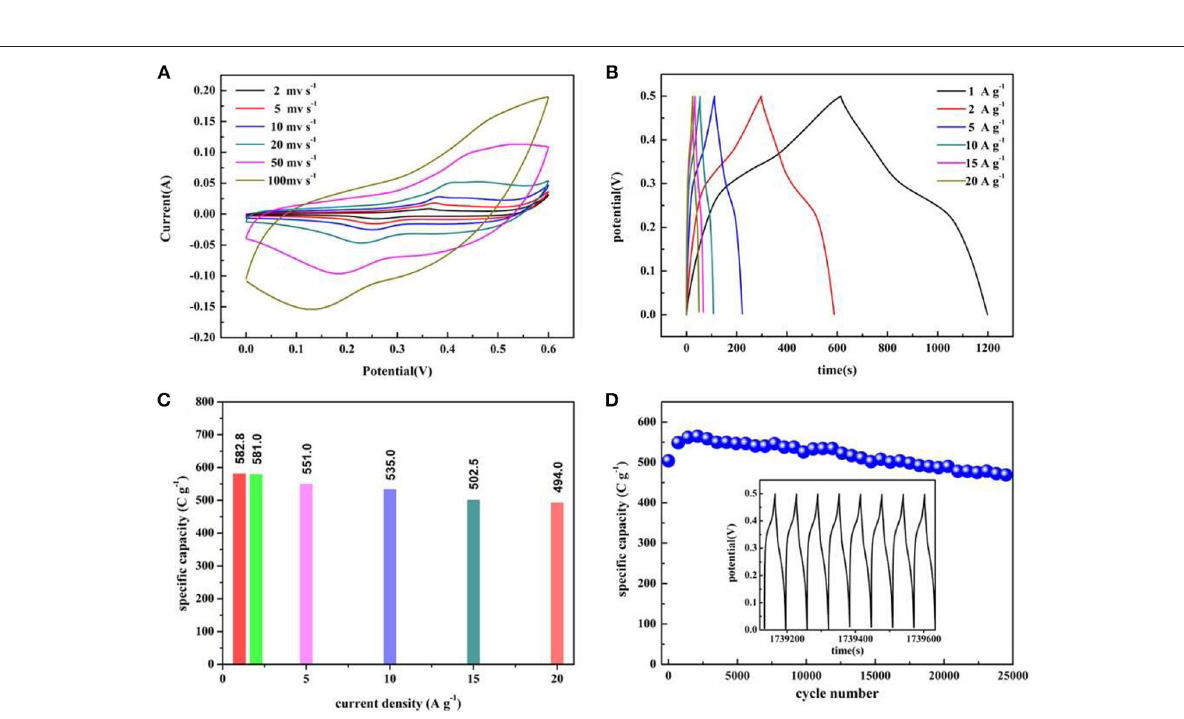
Frontiers in Chemistry | www.frontiersin.org